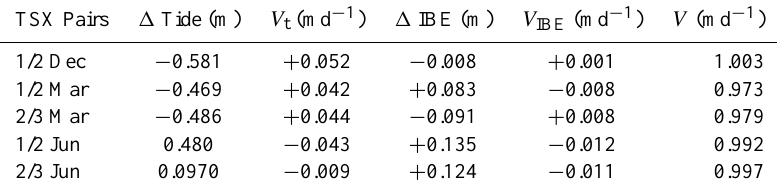
TSX Pairs 1 Tide (m) V t (md − 1 ) 1 IBE